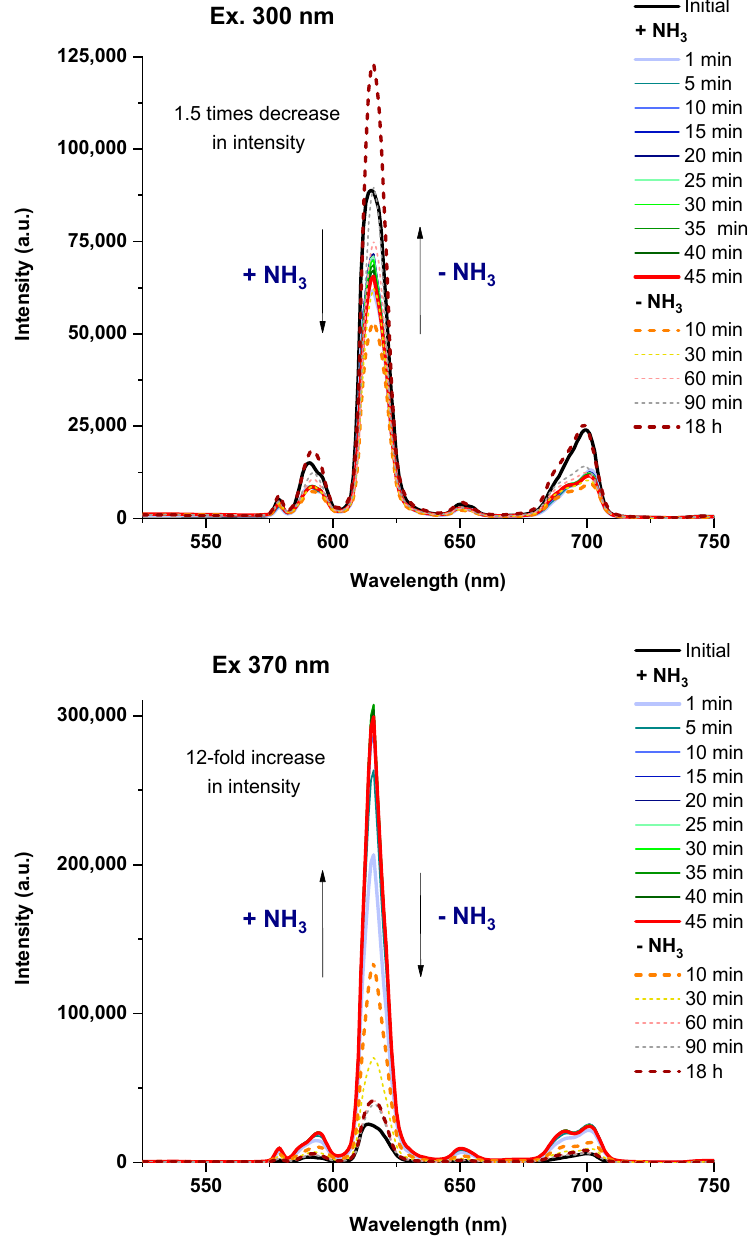
Figure 16. Emission spectra of polymer 8 a when exposed to ammonia vapors with excitation at 300 ( top ) and 370 nm ( bottom ).